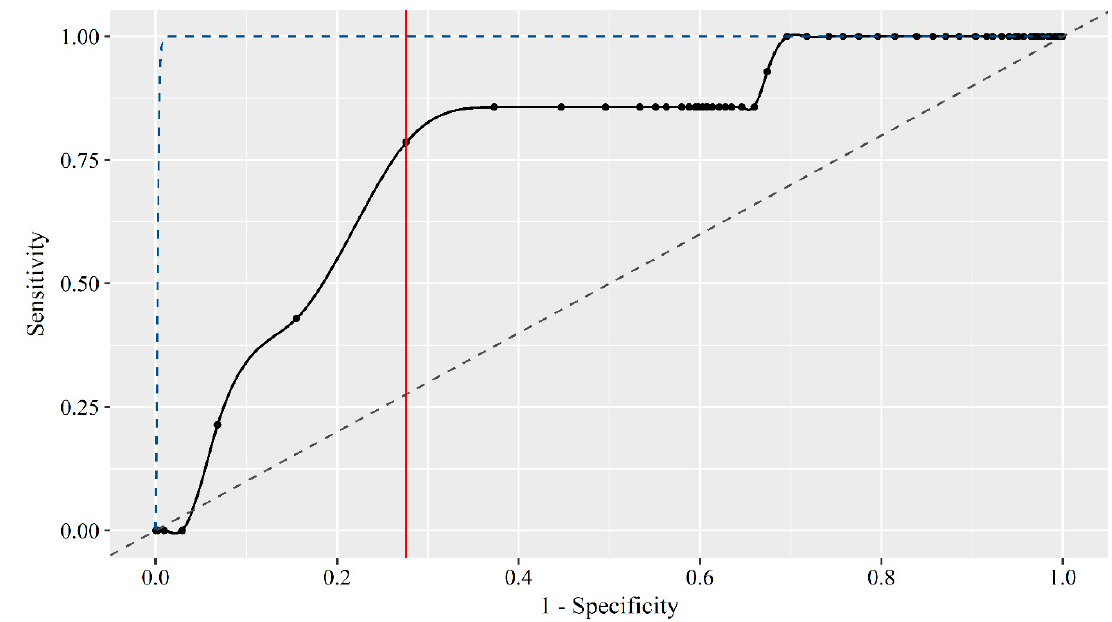
Figure 4. Receiver operating characteristic (ROC) curve for the best performing prediction algorithm of tail biting events in a real-life setting being a Bayesian ensemble combination of all four data sources within the alarm type UNTIMED (day-1, day-2 and day-3). The black solid line and points represent the specificity and sensitivity at different classification thresholds. The grey dashed line represents a prediction algorithm equal to random guessing, whereas the blue dashed line represents a prediction algorithm with an ideal performance. The red solid vertical line represents the best classification threshold being the one with the highest sum of sensitivity and specificity.